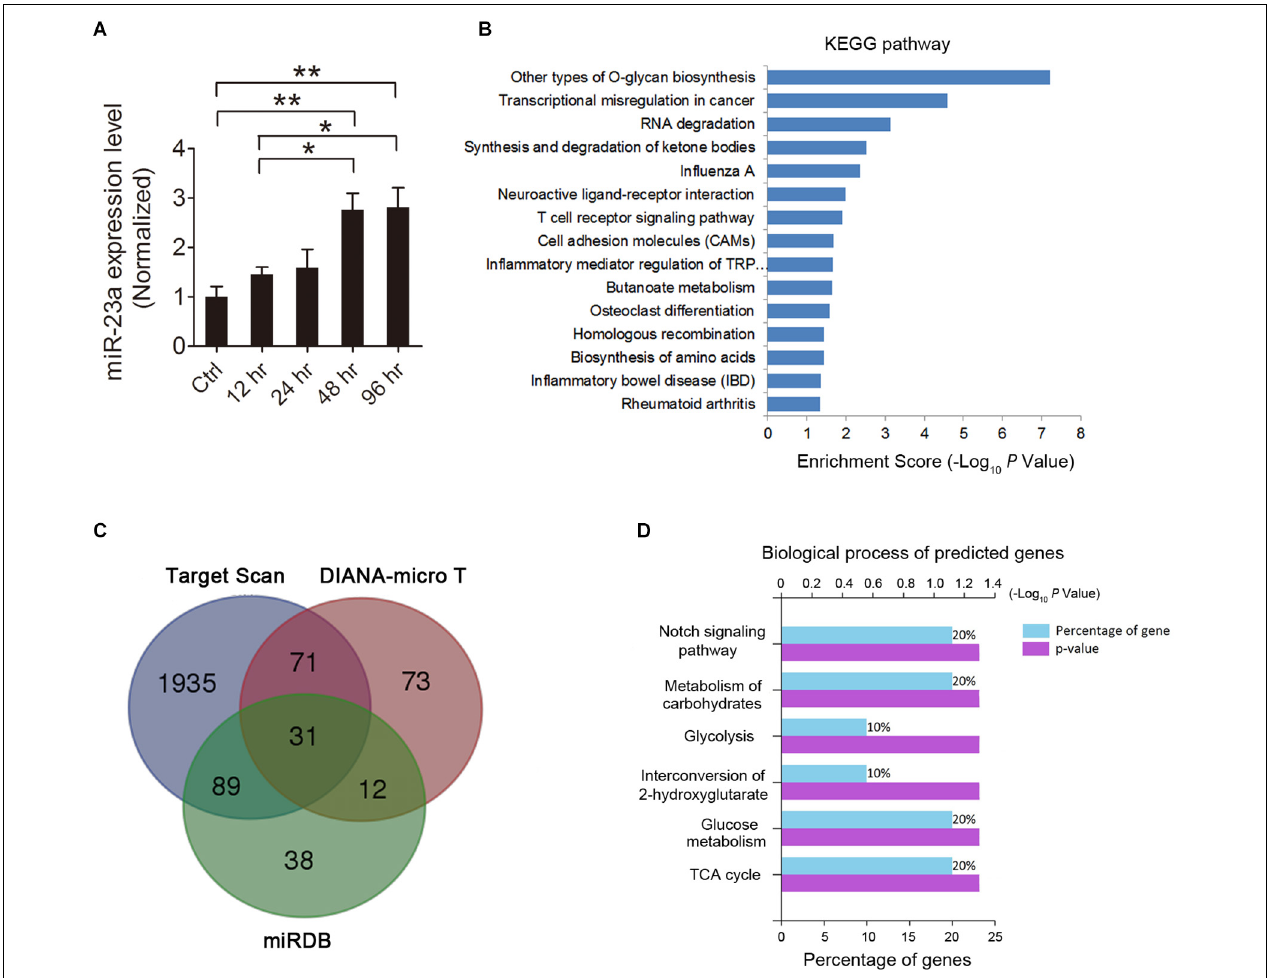
FIGURE 1 | MicroRNA-23a (miR-23a) expression is increased in the hippocampus of temporal lobe epilepsy (TLE) mice. (A) Quantitative real-time PCR (qRT-PCR) analysis of miR-23a expression in the hippocampus of ctrl, 12, 24, 48, and 96 h post-status epilepticus (SE) mice ( F 4 , 20 = 7.07, p = 0.005, 48 h vs. ctrl; p = 0.004, 96 h vs. ctrl; p = 0.048, 48 vs. 12 h; p = 0.038, 96 vs. 12 h) ( n = 5). (B) KEGG enrichment analysis of the association of miR-23a expression with enriched signaling pathways by using mirPath software. (C) Venn diagram showing the predicted target genes of miR-23a by three microRNA target prediction databases, including TargetScan, DIANA-MicroT, and miRDB. (D) GO analysis in terms of biological processes for the determination of the biological significance of the predicted miR-23a target intersection genes by the FunRich database. Values are mean ± SEM. ∗ p < 0.05, ∗∗ p < 0.01, one-way